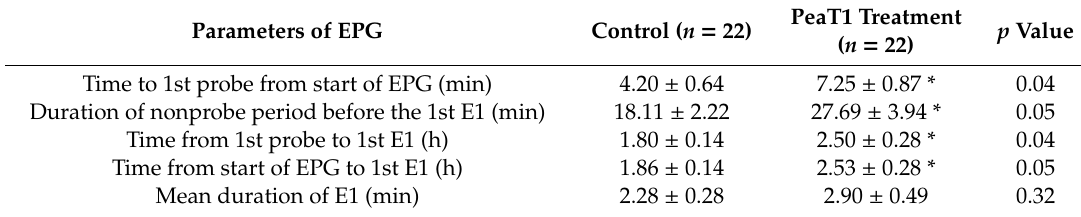
PeaT1 Treatment p Value ( n = 22)